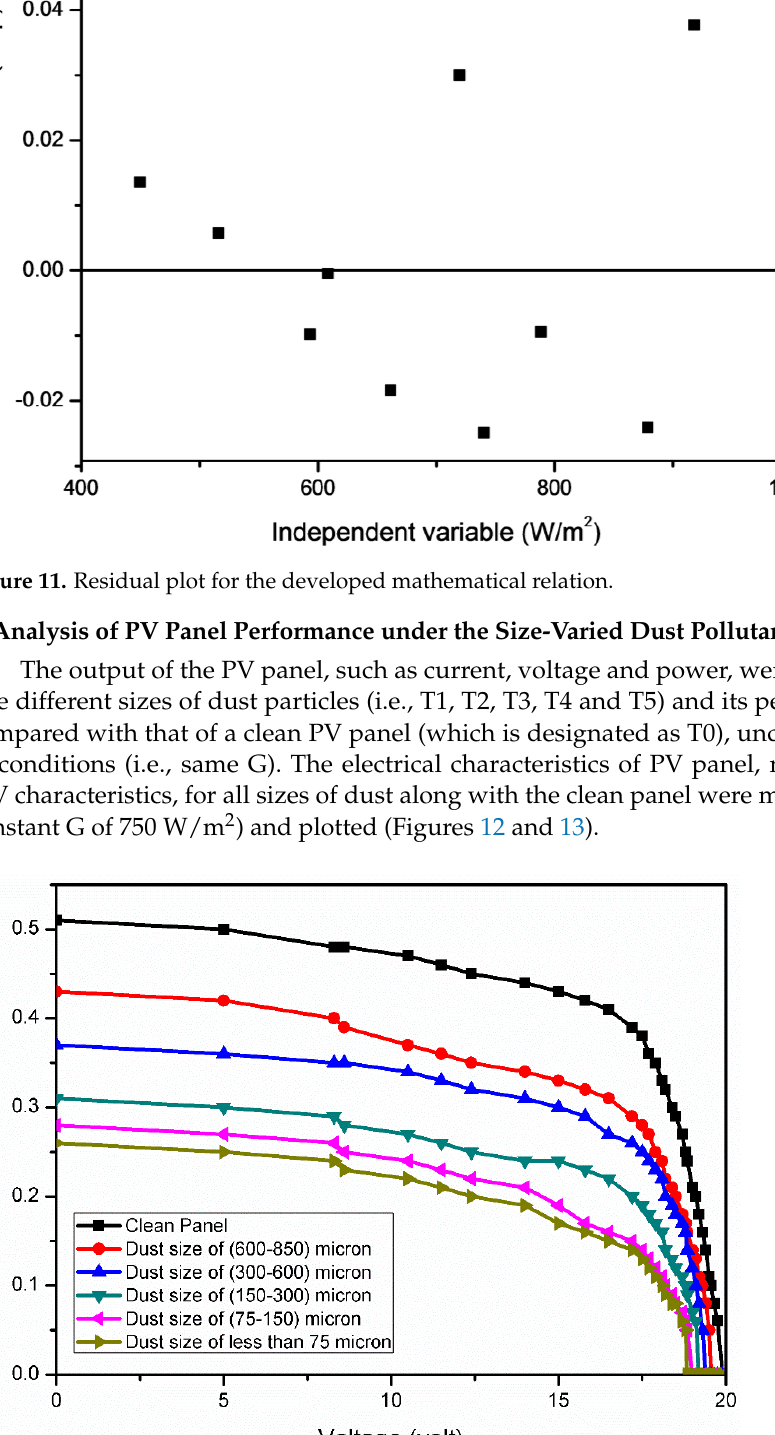
Figure 13. P-V curves of the solar PV panel for different dust size . From Figure 12, the percent reduction in Isc of the PV panel was calculated using Equation (20) for different sizes of dust particles, and shown in Table 8. 𝑅𝑆𝐶𝐶 = I sc,clean − I sc,dusty I sc,clean × 100 (%) (20) where, RSCC =reduction in short-circuit current (%),I sc,clean = short-circuit current of clean PV panel, and I sc,dusty = short-circuit current of dusty PV panel (amp).